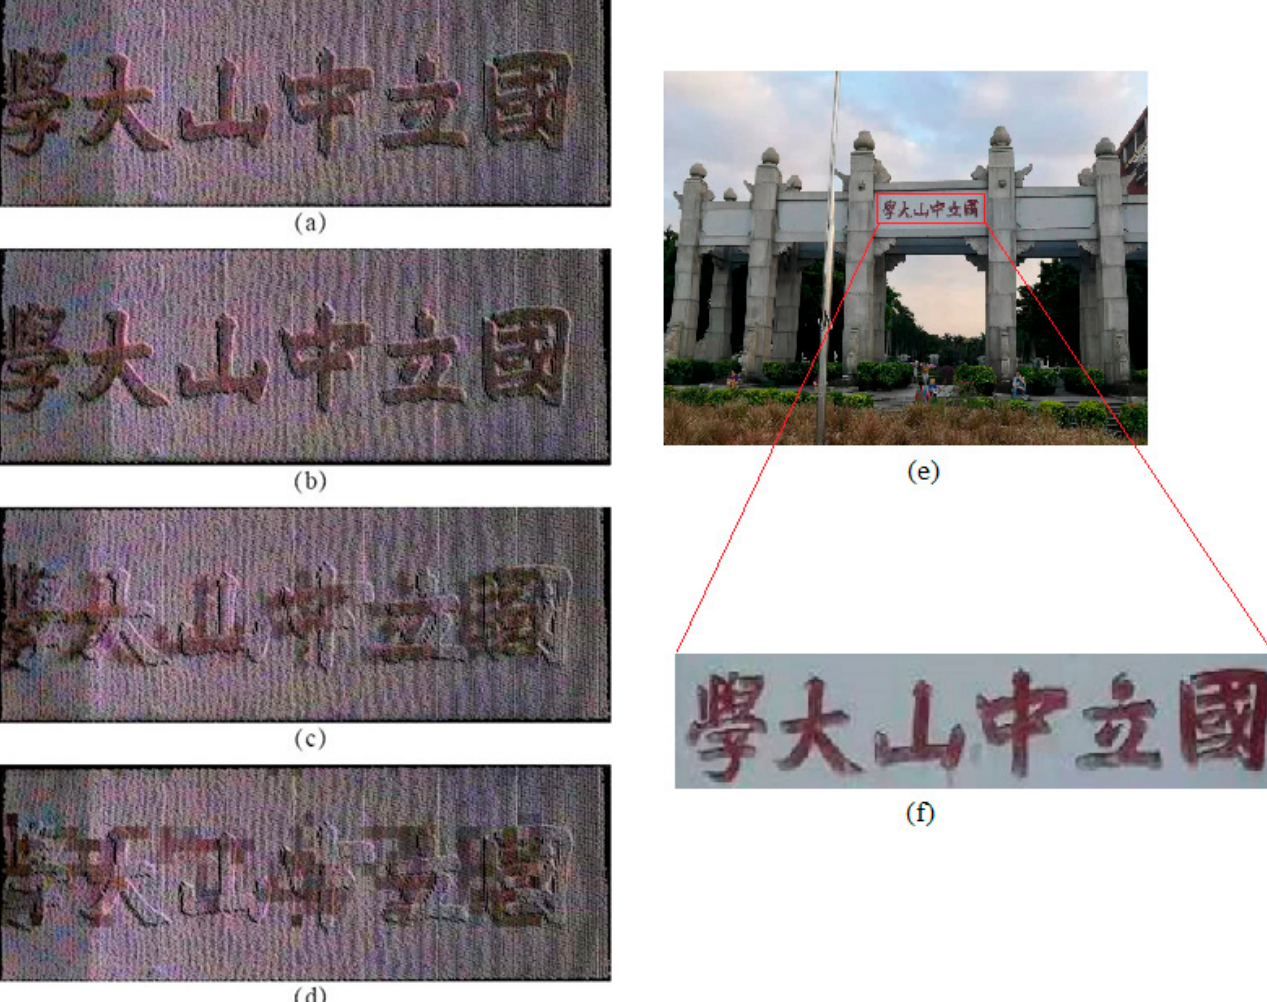
Figure 10. Original and the colorized point cloud (captured at different T ‐ C distances under the simulation) of the facia